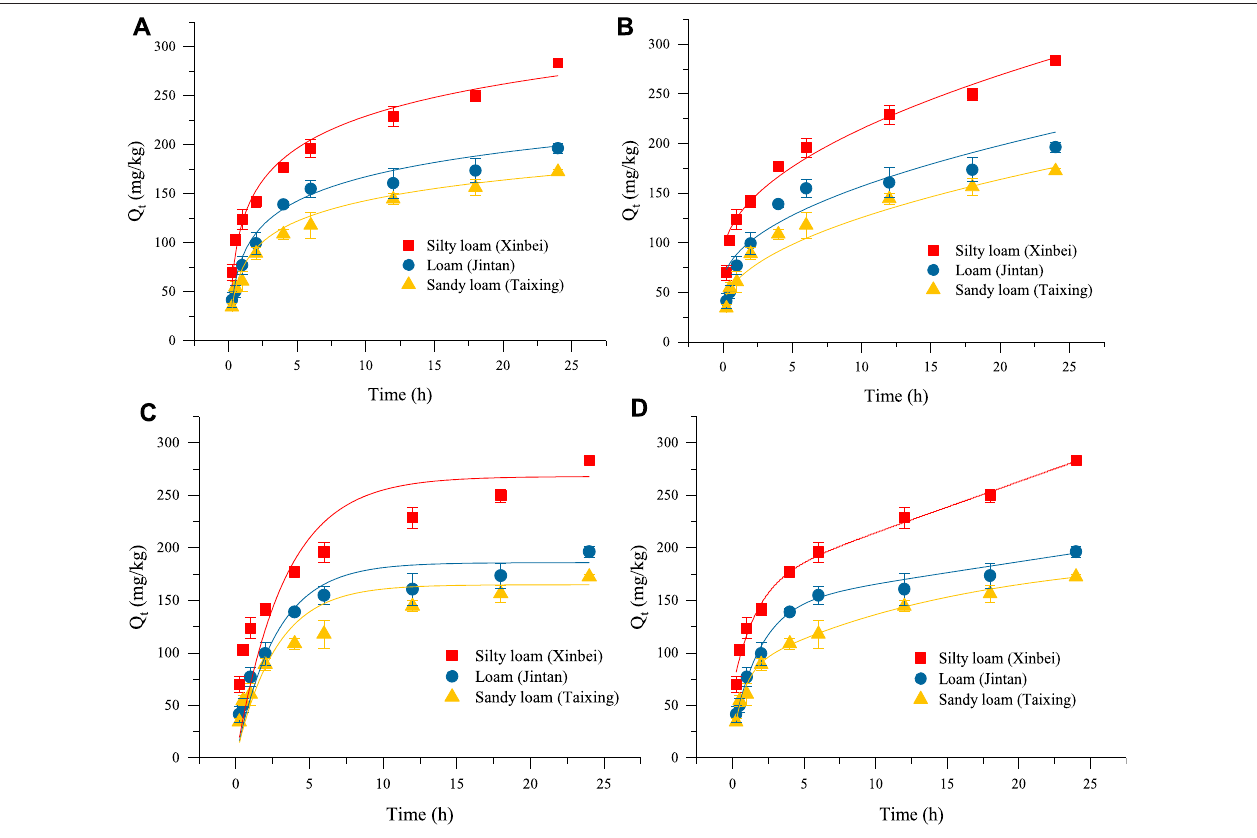
FIGURE 2 | Fitting of adsorption kinetics models: (A – D) show the fi tting results for the adsorption kinetics of NH 4+ -N in the three kinds of soils obtained by the Elovich equation, a parabolic diffusion equation, a fi rst-order reaction equation, and the ExpAssoc equation, respectively.